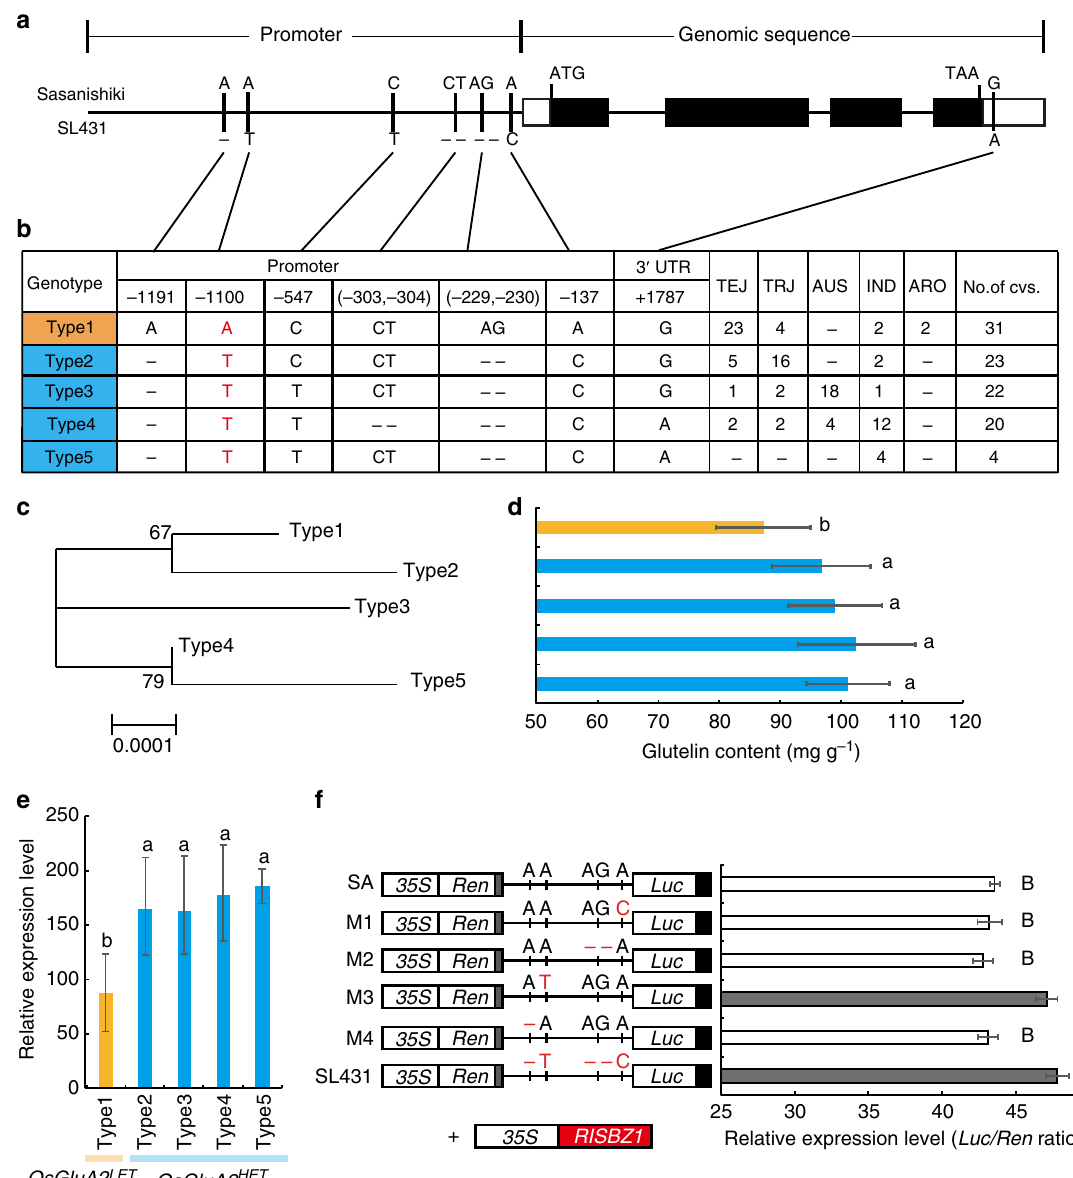
Fig. 4 Haplotype analysis of OsGluA2 . a Schematic of the gene structure and allelic variation on OsGluA2 between Sasanishiki and SL431 indicated by vertical lines at bottom. b Haplotype analysis of the OsGluA2 gene region from 100 rice cultivars. IND indica population, TEJ temperate japonica population, TRJ tropical japonica population, ARO aromatic population. c Phylogenetic tree of the fi ve haplotypes. d Analysis of the glutelin content in representative varieties with fi ve different haplotypes. n = 8 in type 1, n = 7 in type 2 and type 3, n = 6 in type 5, and n = 2 in type 5. e The relative expression level of the fi ve haplotypes. Cultivar number of type 1, type 2, type 3, type 4, and type 5 haplotype was 8, 7, 7, 6, and 2, respectively. Three replicates of each cultivar were used for the analyses. f Transient expression assay of promoter activity in rice protoplasts. n = 10. Left, constructs with site-directed mutations at the four SNPs in the promoter region. Right, relative Luc/Ren values. Error bars, s.d. The presence of the same capital letter denotes a non-signi fi cant difference between them ( P > 0.01). P -values were calculated by one-way ANOVA. Source data of Fig. 4d – f are provided as a Source Data fi